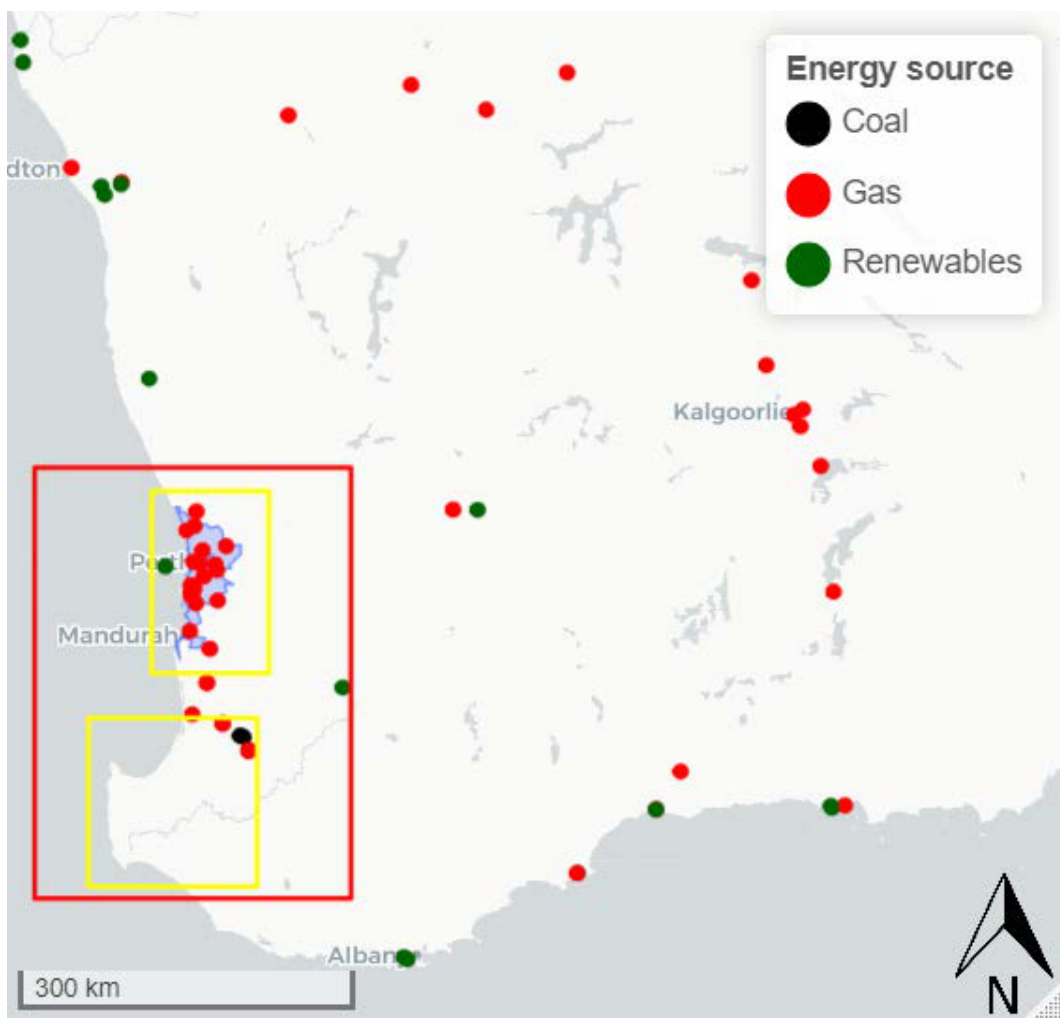
Figure 2. SWIS Network and location of power stations. Type of energy source shown as colour coded circles and the GMR Perth is shown in blue. Study region is enclosed within the red rectangle and two sub-regions (GMR Perth and region to southwest of Perth) enclosed within yellow rectangles.